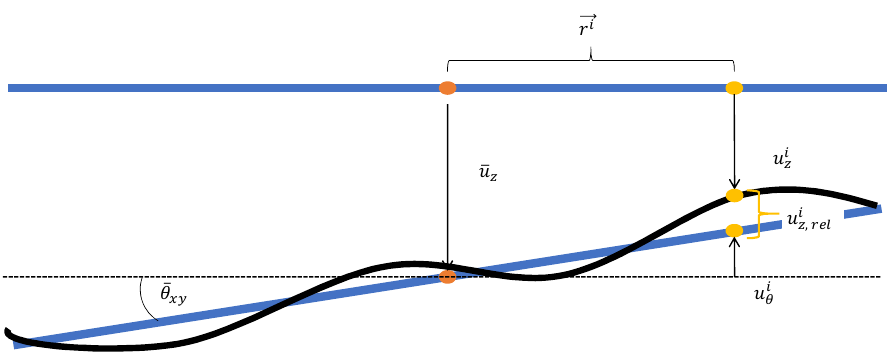
Figure 1. Deformation of mirror calculated from